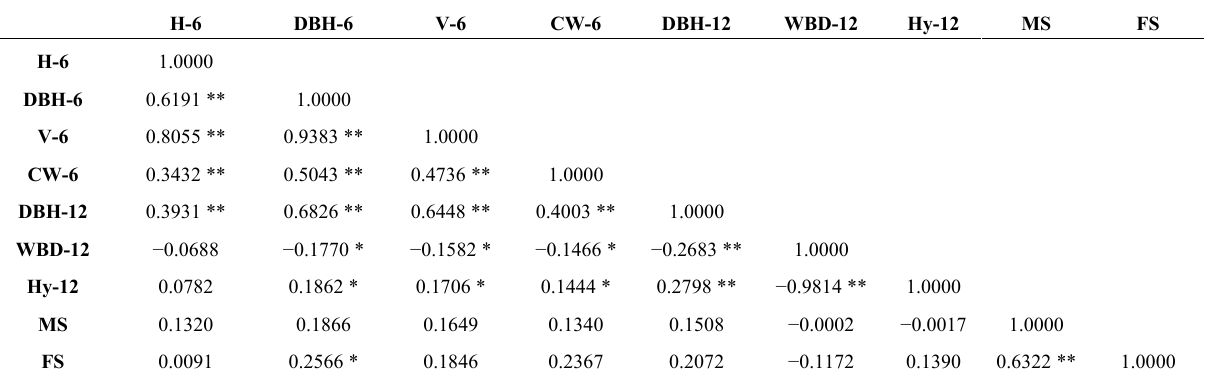
Table 3. Phenotypic correlations among morphological traits in Chinese fir. H-6, tree height at age 6; DBH-6, diameter at breast height at age 6; V-6, stem volume at age 6; CW-6, crown-width at age 6; DBH-12, diameter at breast height at age 12; WBD-12, wood basic density at age 12; Hy-12, wood hygroscopicity at age 12. MS, the number of male strobili; FS, the number of female strobili. * p < 0.05, ** p < 0.01. The degrees of freedom (df) for